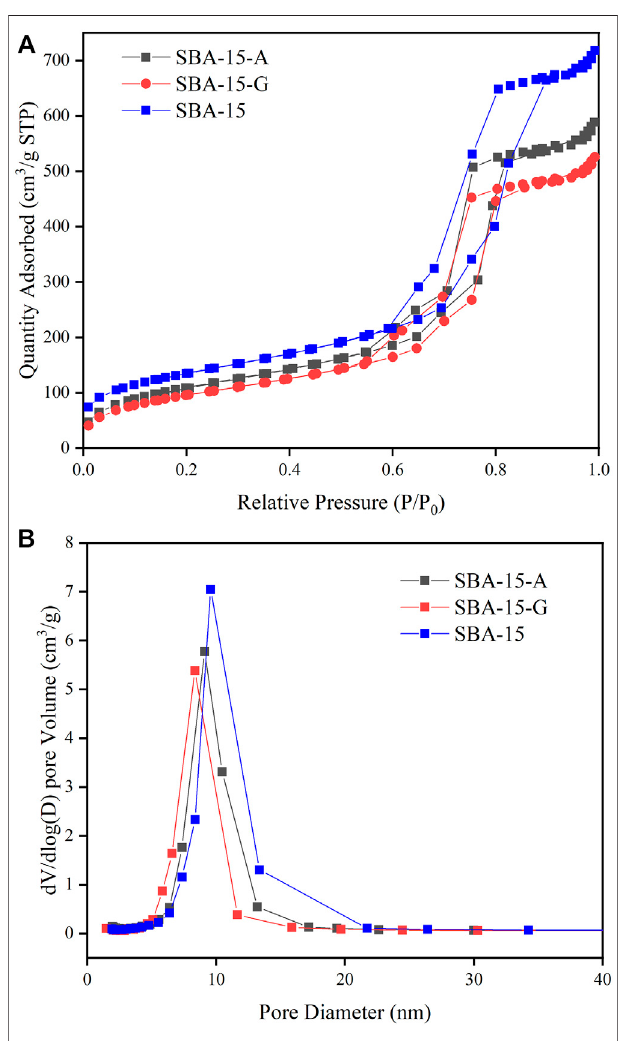
FIGURE 1 | (A) : The adsorption isotherms of SBA-15, SBA-15-A, and SBA-15-G. (B) : The pore size distribution curves of SBA-15, SBA-15-A, and